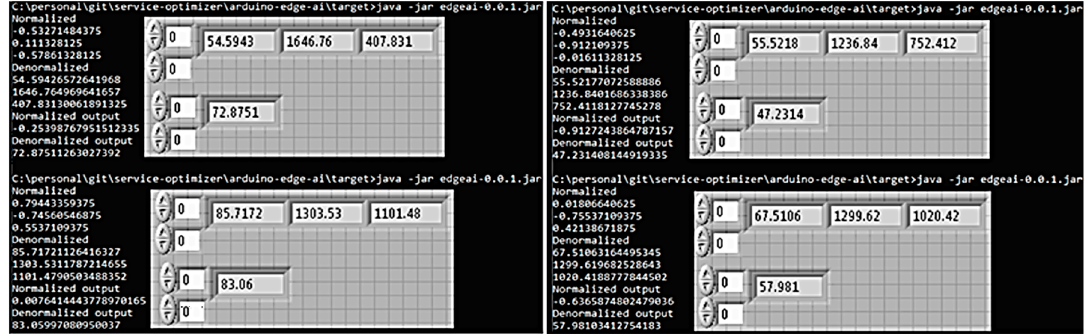
Figure 20. Examples of the compact edge AI code run (black) with the corresponding virtual instrument (VI) test verification (grey) for un-normalized